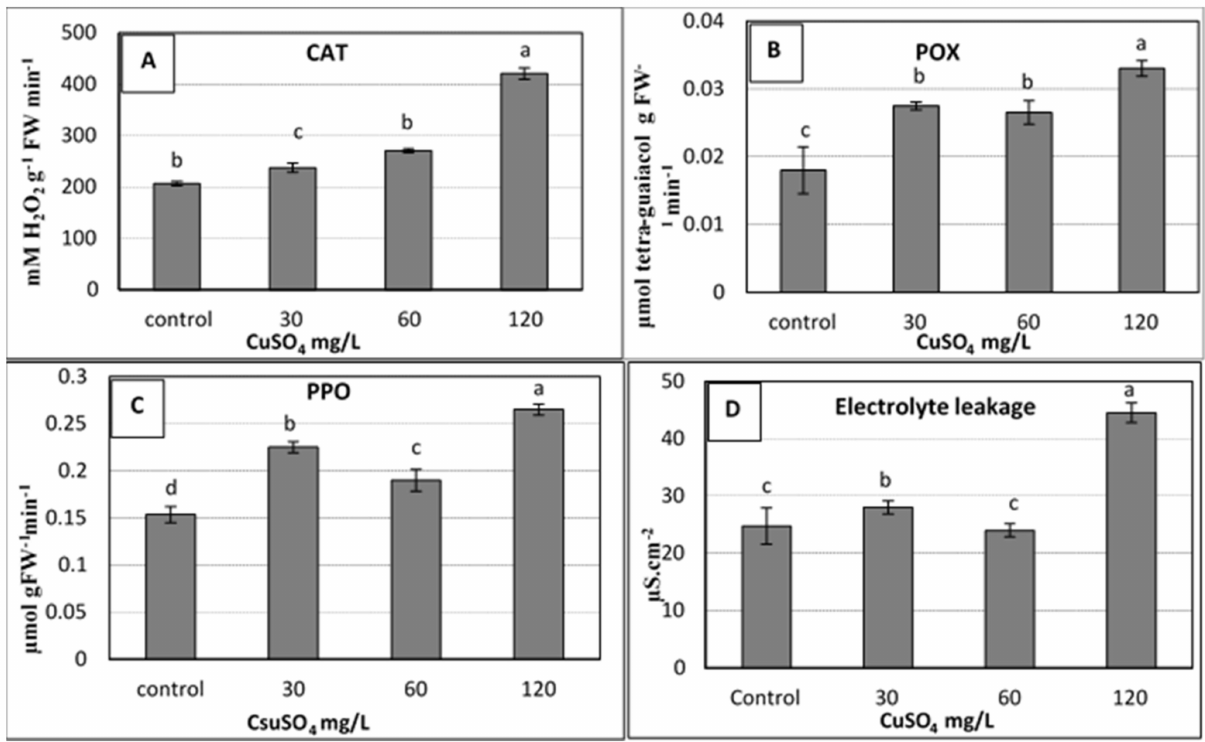
Figure 3. Effect of copper sulphate at 0.025, 30, 60, 120 mg L − 1 on the activity of antioxidant enzymes: [( A ) Catalase; ( B ) Peroxidases; ( C ) Polyphenol oxidase] and ( D ) Electrolyte leakage of banana shoots cultured in rooting medium (1 mg L − 1 IBA) after 4 weeks of culture. Data represent the mean with SE. Letters above each bar shown the significant differences among the tested treatment, if letters were same corresponding treatments are statistically equal and vice versa according to Duncan’s multiple range tests at p < 0.05. Control = 0.025 mg L − 1 and represents the concentration of CuSO 4 5H 2 O in MS medium (without copper sulphate